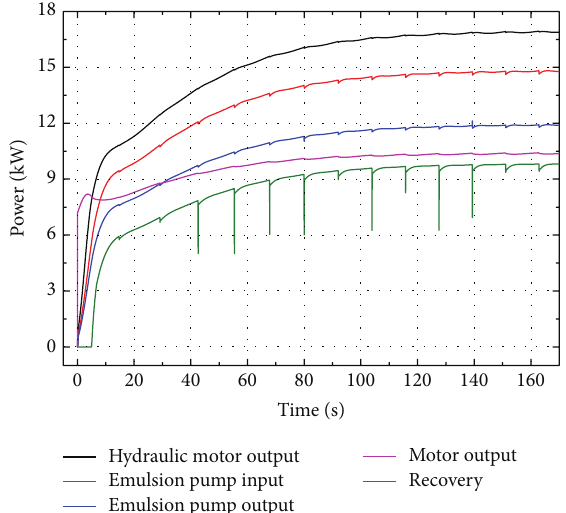
Figure 12: Power consumption of major components by simulation.